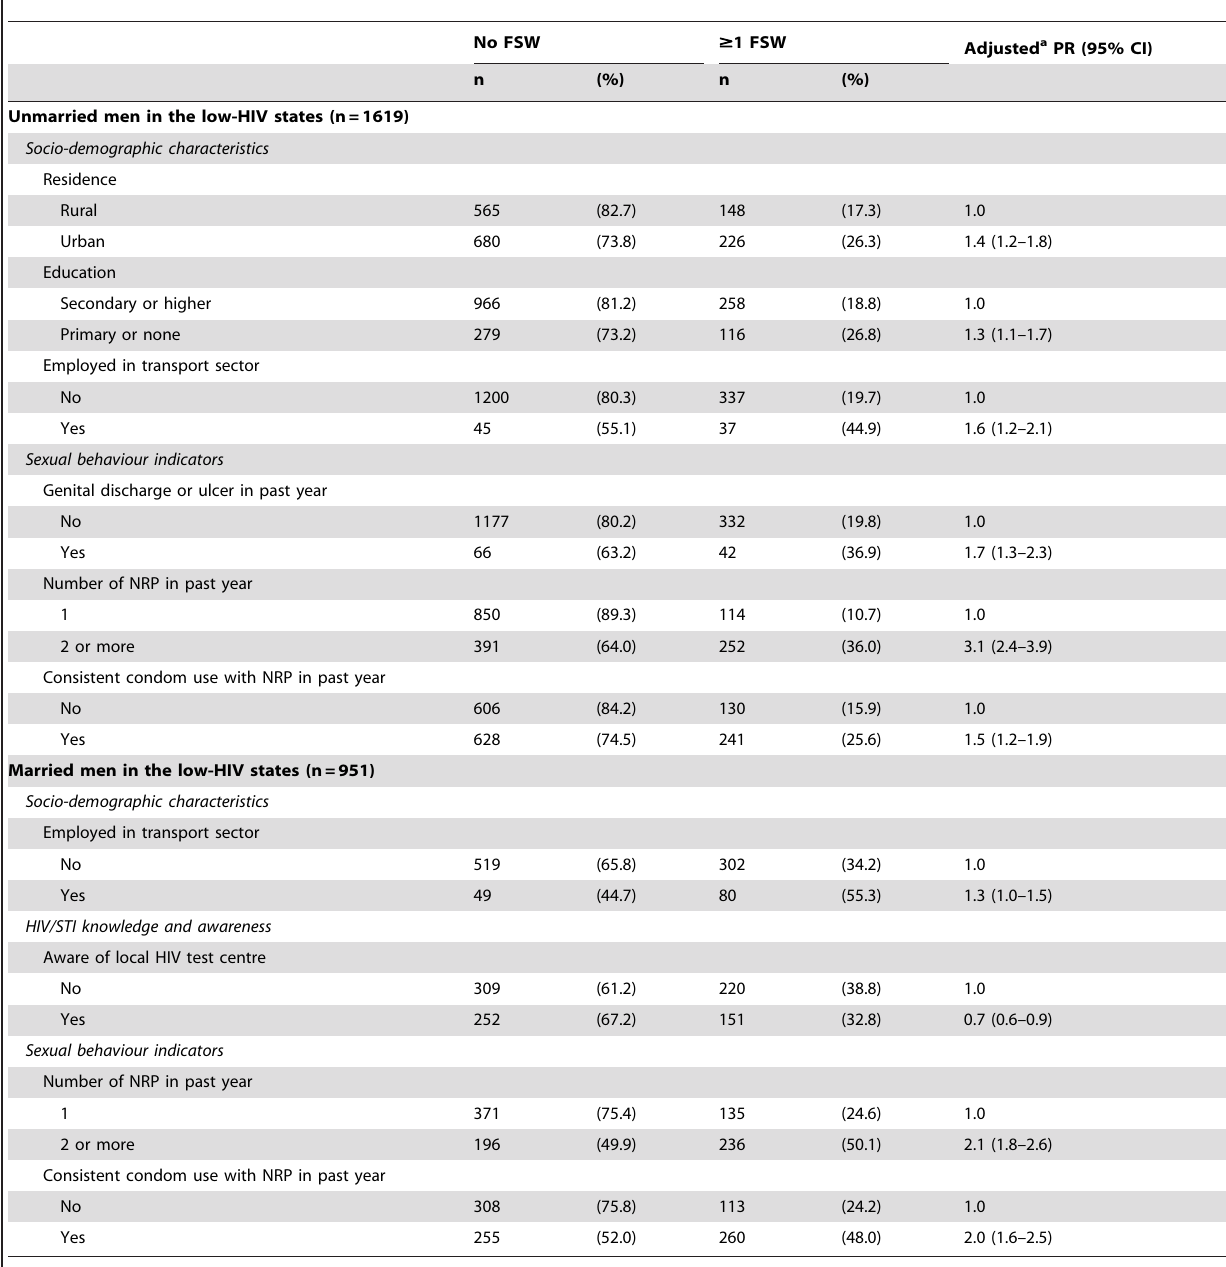
Table 4. Factors associated with using female sex work among Indian men reporting any non-regular partner in the past year in the low-HIV states,